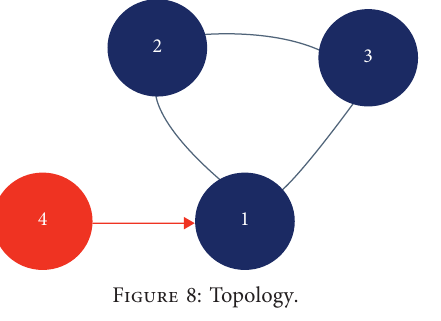
Figure 8: Topology.